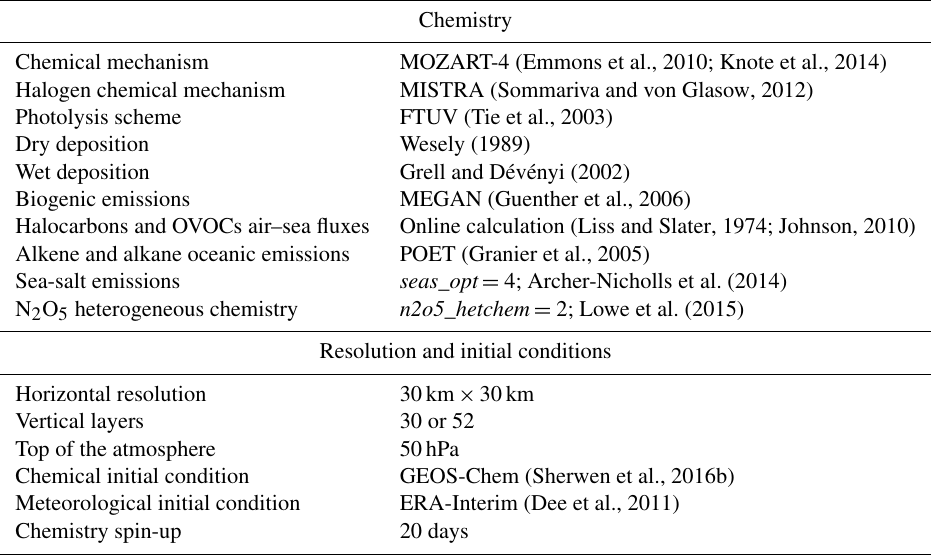
Table 6. Model details and experiment configuration.